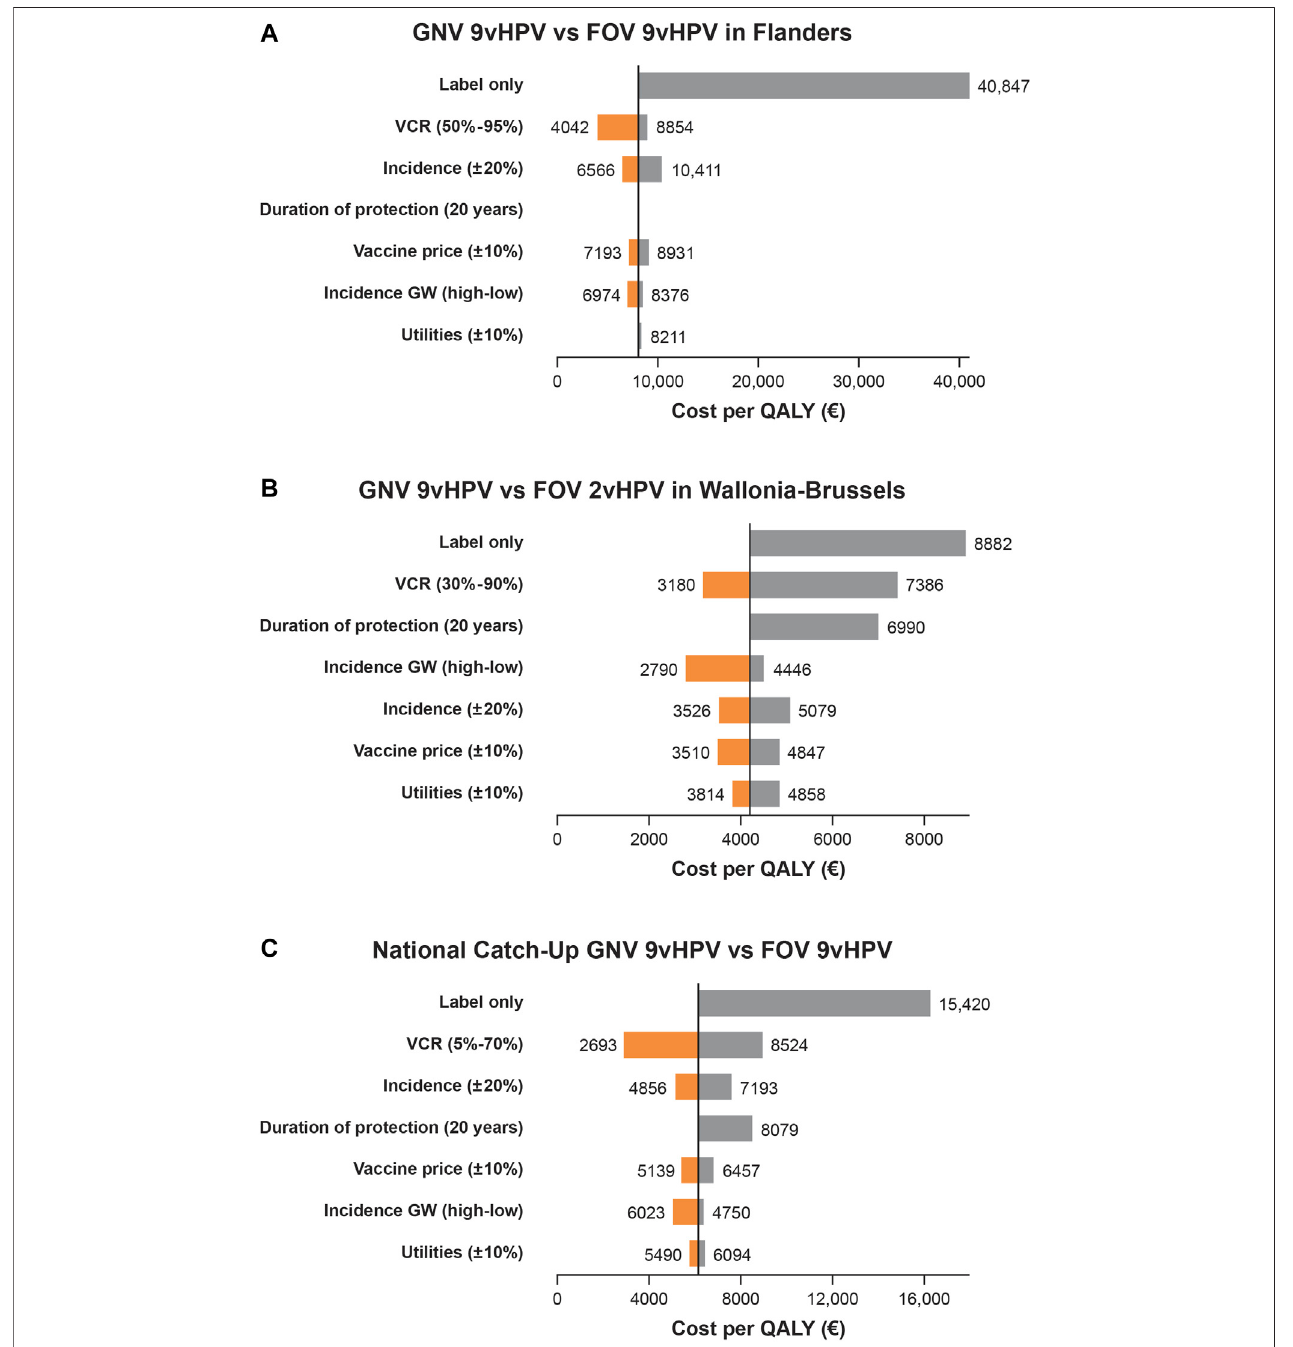
FIGURE 2 | Univariate sensitivity analyses of the base case for the incremental cost-effectiveness ratio (ICER; cost per QALY) of gender-neutral vaccination (GNV) with the 9vHPV vaccine in the Flanders Region of Belgium versus female-only vaccination [FOV] with the 9vHPV Vaccine) (A) ; in the Wallonia-Brussels region of Belgium versus FOV with the 2vHPV vaccine (B) ; and as part of a national HPV vaccine catch-up program compared with FOV with the 9vHPV vaccine in Belgium (C) over 100 years a Sensitivity analyses assessed ICER with 9vHPV GNV vs 2vHPV FOV, and 9vHPV GNV vs 9vHPV FOV with: a genital warts incidence rate of 76 per 100,000(low)and250per100,000(high);lower(-20%)andhigher(+20%)incidenceofHPV-relatedcancers;label-onlyindicationsforthe9vHPVvaccine(genitalwarts, precancerouslesions[CIN1/2/3,VIN2/3,VaIN2/3,analintraepithelialneoplasia1/2/3],cervical,vulvar,vaginal,andanalcancersforfemales;andgenitalwartsandanal cancer for males); duration of protection of 20 years; vaccine price discount of ± 10%; and utilities of ± 10%.